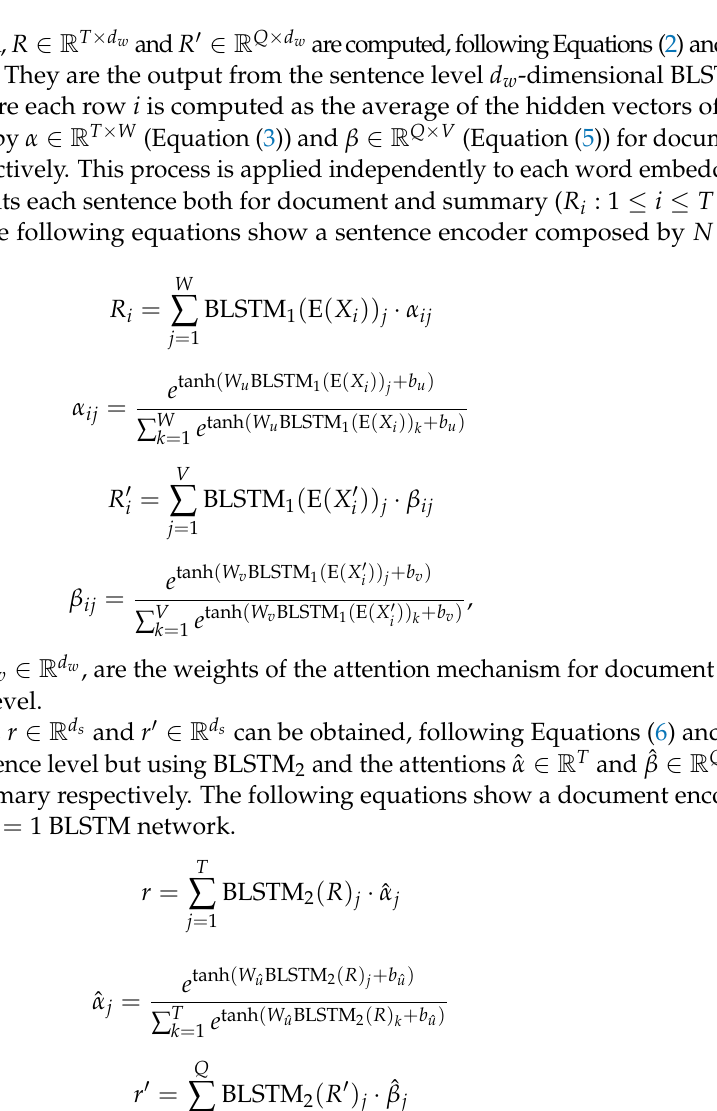
Figure 2. SHA-NN